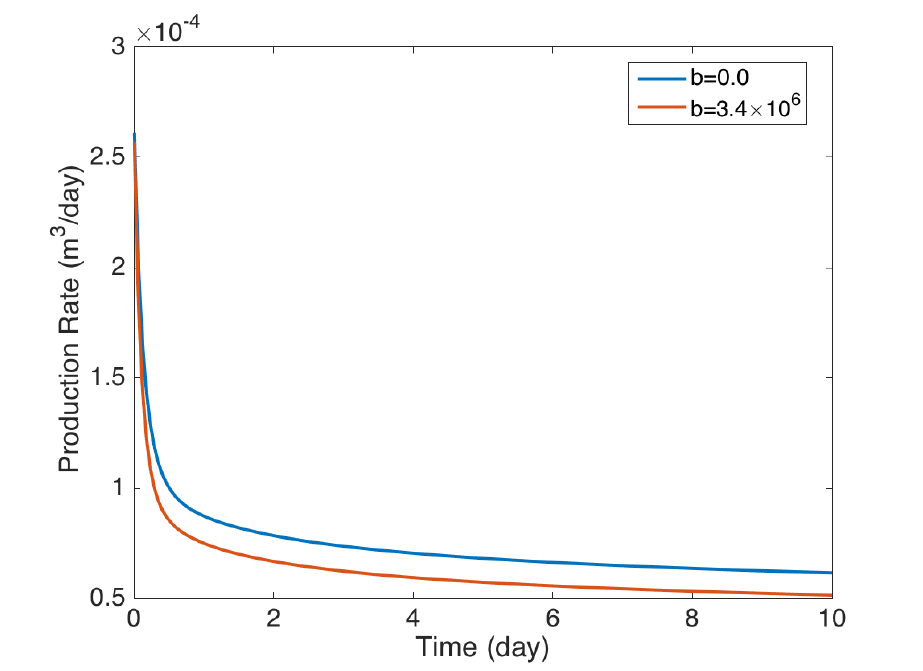
Figure 3. The production rate for various values of the coefficient